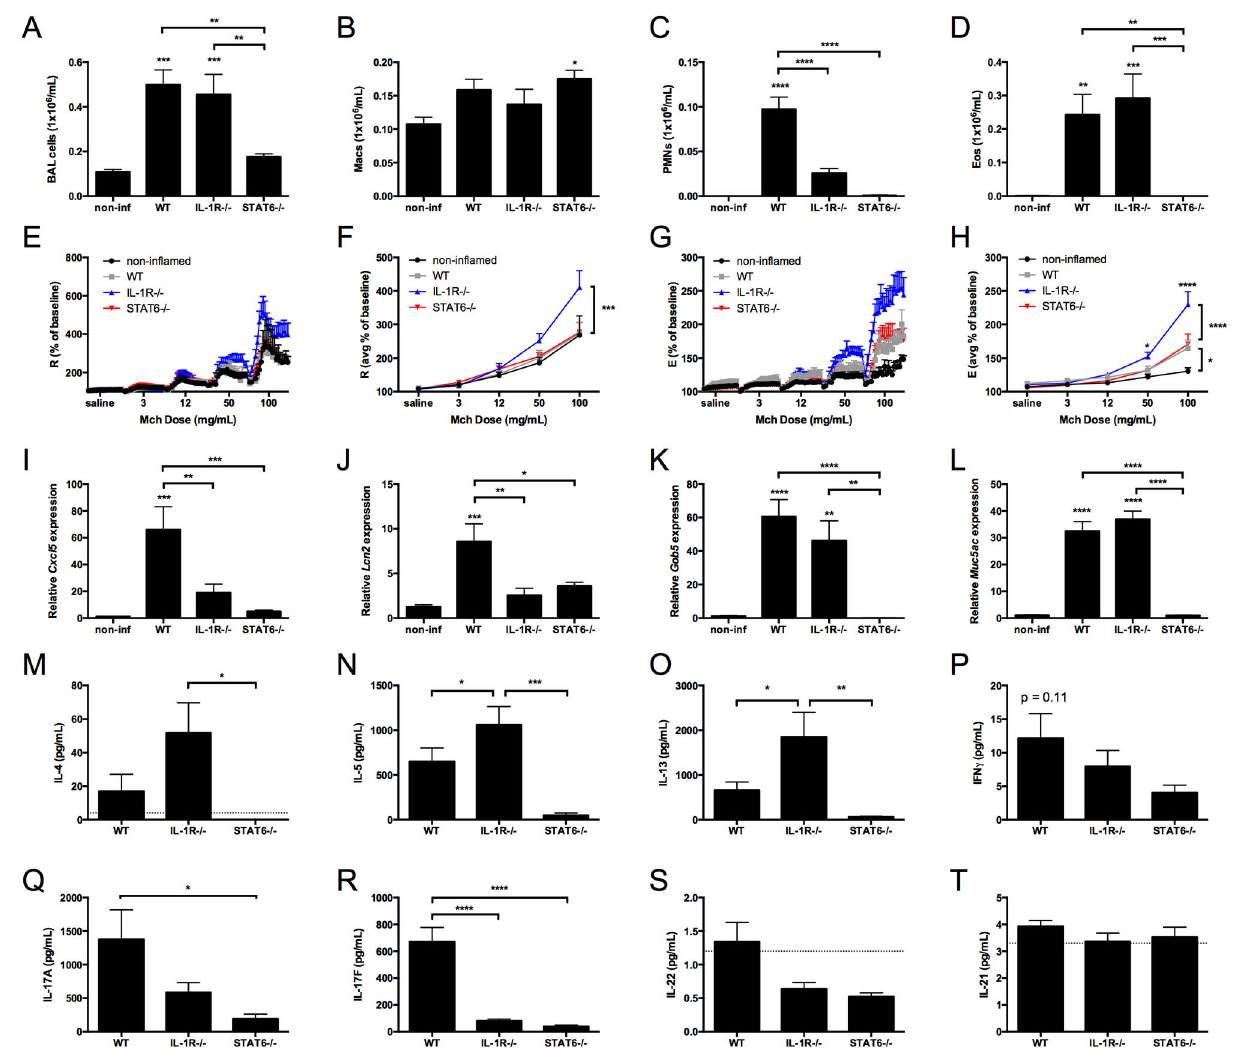
Figure 3. The absence of the IL-1R-dependent Th17 response in NO -promoted allergic airway disease correlates with 2 exacerbation of AHR. C57BL/6 (WT), IL-1R-/-, and STAT6-/- mice were subjected to NO -promoted allergic sensitization, 2 challenged, and analyzed 48 hours following the final antigen challenge. BAL total cells were quantified (A) and Macs (B), PMNs (C), and Eos (D) were calculated based on cell fractions. Methacholine responsiveness was performed by invasive forced oscillation technique. The percent baseline and average percent baseline per dose of methacholine were calculated for R (E-F) and E (G-H), as determined by the single-compartment model [47]. Quantitative RT-PCR was performed to measure gene expression for Cxcl5 (I) , Lcn2 (J), Gob5 (K), and Muc5ac (L). Th2 cytokines IL-4 (M), IL-5 (N), and IL-13 (O), the Th1 cytokine IFNγ (P), and the Th17 cytokines IL-17A (Q), IL-17F (R), IL-22 (S), and IL-21 (T) were quantified by Milliplex. The dashed line in M, S, and T signifies the lower limit of detection in the assay. Statistics were performed by 1-way ANOVA (A-D and I-T) or 2-way ANOVA (F and G) and Tukey post-hoc analysis. **** p < 0.0001, *** p < 0.001, ** p < 0.01, * p < 0.05 compared to non-inflamed unless otherwise